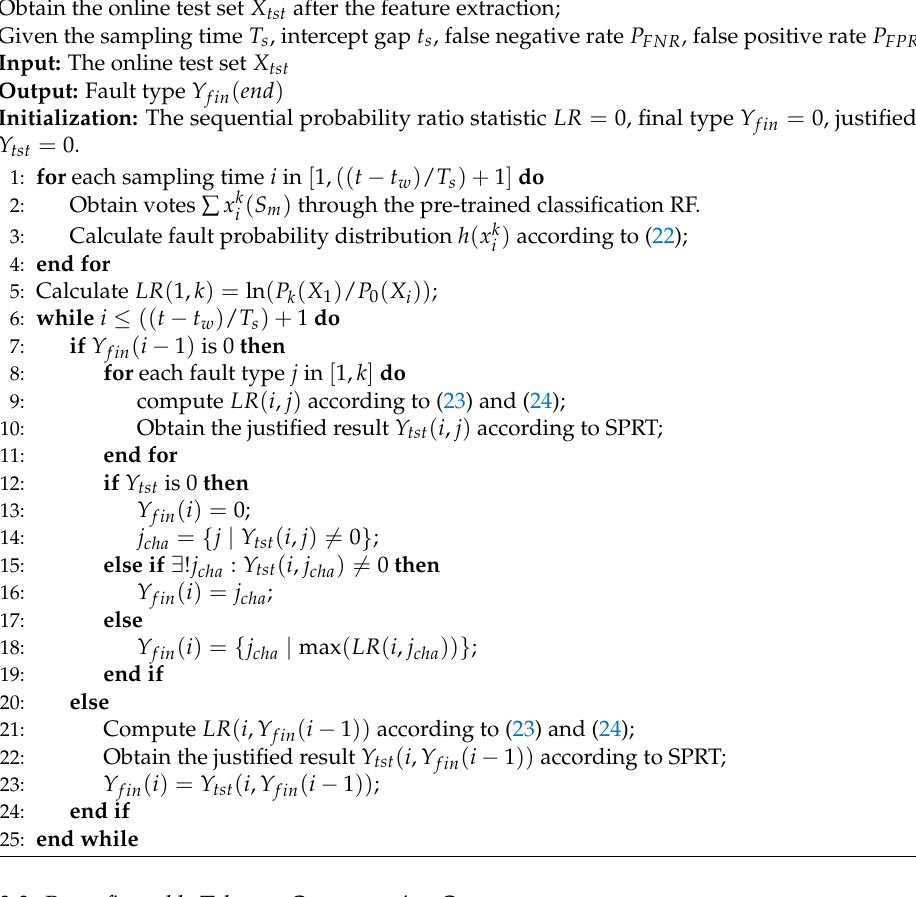
Algorithm 1 The auto sequential RF-based online fault isolation procedure Obtain the online test set X tst after the feature extraction; Given the sampling time T s , intercept gap t s , false negative rate P FNR , false positive rate P FPR